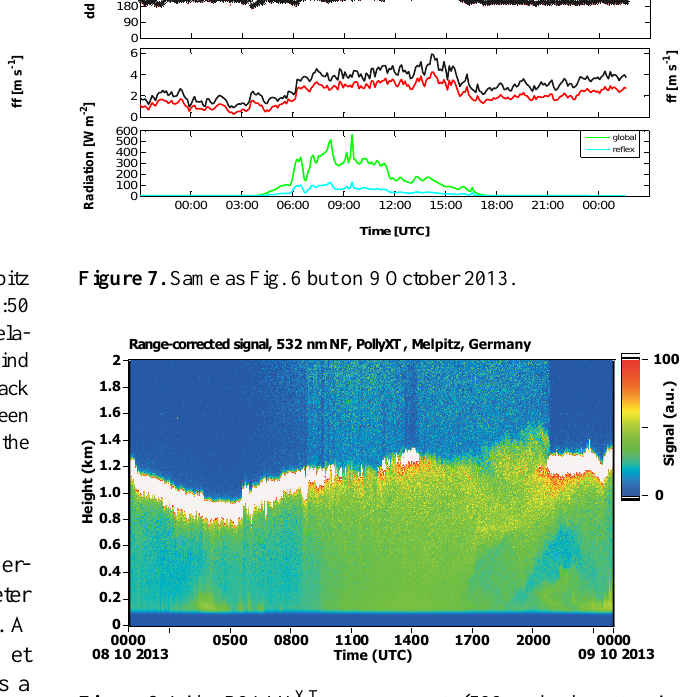
Figure 8. Lidar POLLY XT measurements (532nm backscatter sig- nal) in Melpitz on 8 October